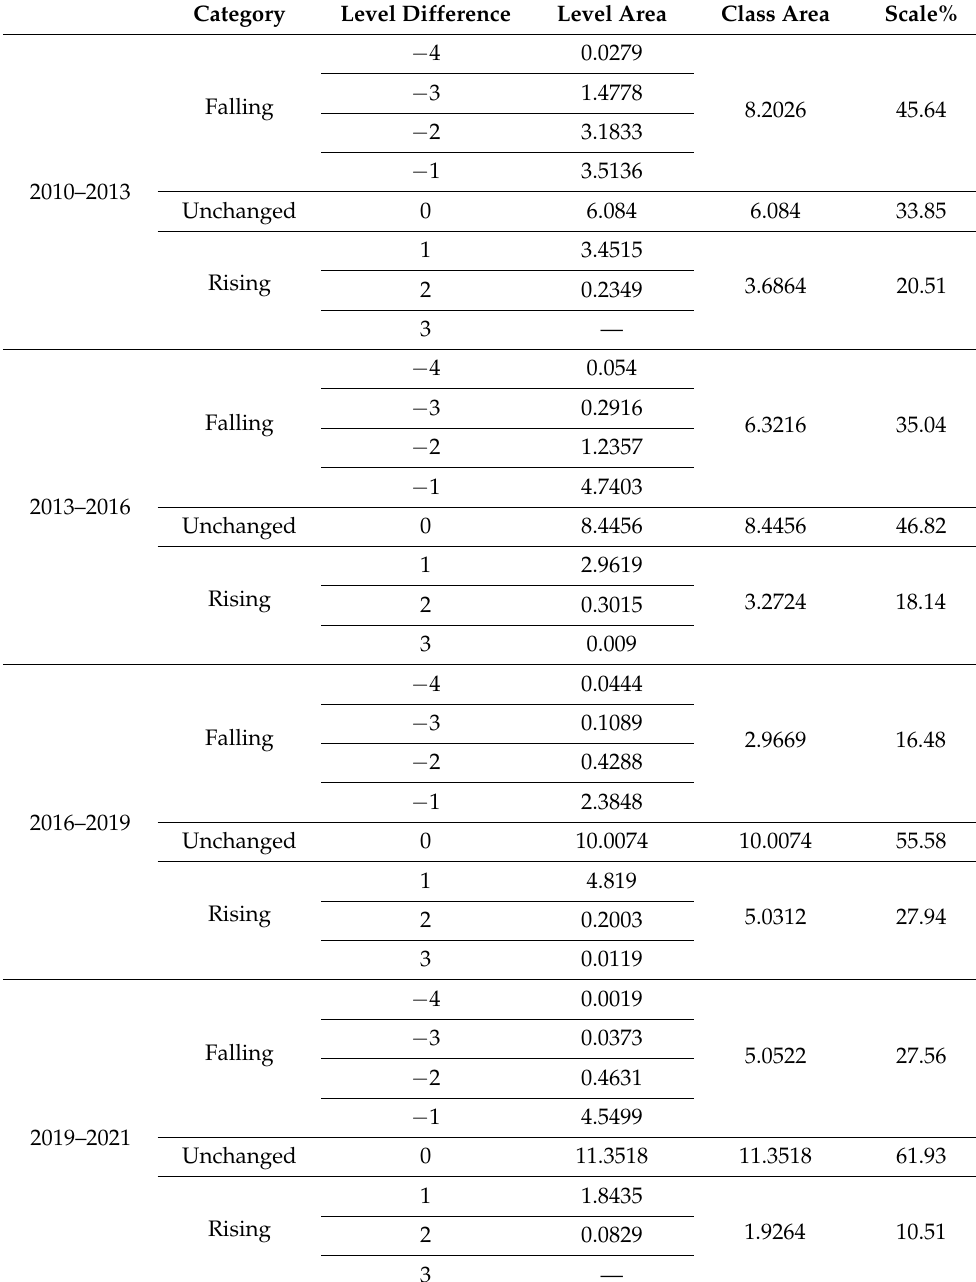
Table 7. Statistics on the change of RSEI from 2010 to